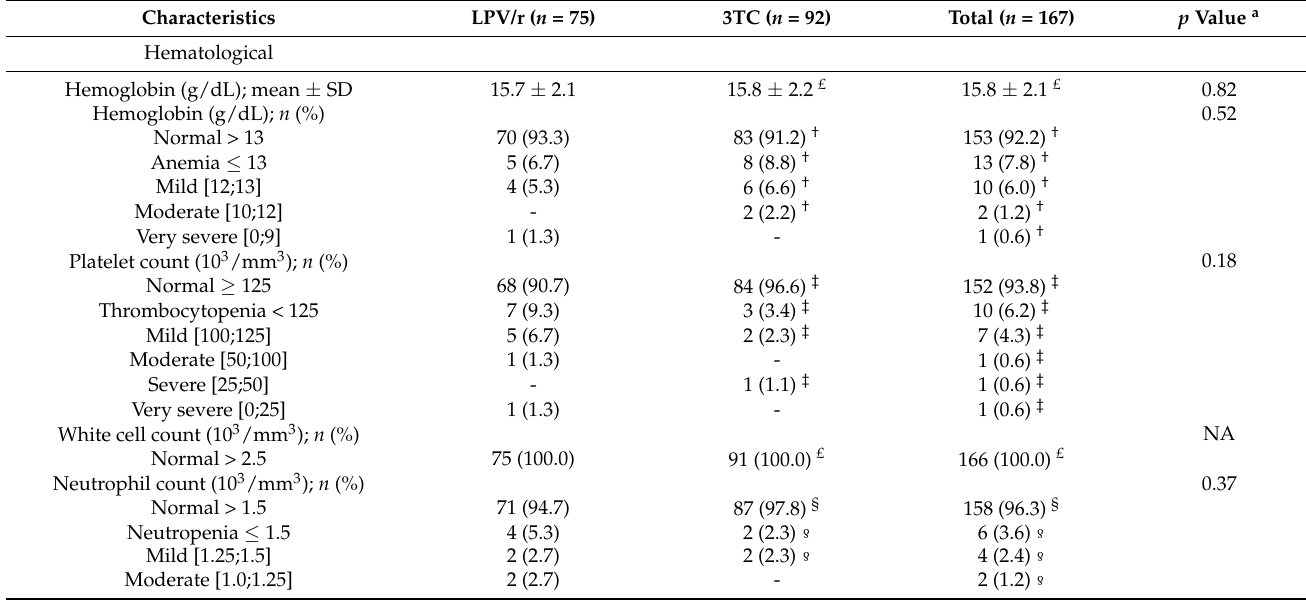
† one missing value, § three missing values, ‡ five missing values, £ two missing values, ʊ six missing values, ƍ three missing values. a Chi- square test or Fisher’s exact test as appropriate and Student’s t -test or Wilcoxon Mann-Whitney test for LPV/r versus 3TC. Abbreviations: SD, standard deviation; LPV/r, lopinavir/ritonavir; 3TC, lamivudine; IQR, interquartile range; WAZ, weight-for-age Z-score, HAZ, height-for-age Z-score; WHZ, weight-for-height Z-score, NA non-applicable.